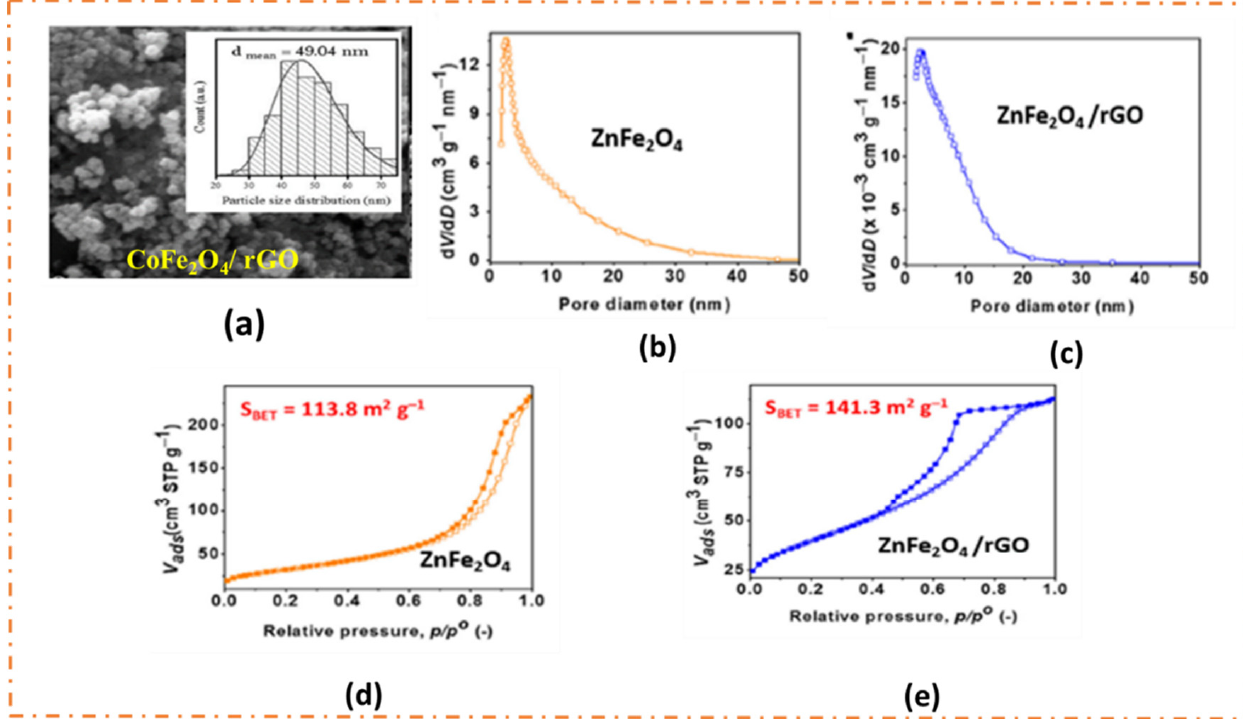
Figure 2. ( a ) FESEM image of CoFe 2 O 4 /rGO composite “Reprinted/adapted with permission from Ref. [40]. 2020, Elsevier”. BJH adsorption pore size distribution curve for ( b ) ZnFe 2 O 4 and ( c ) ZnFe 2 O 4 /rGO; N 2 adsorption–desorption isotherm for ( d ) ZnFe 2 O 4 and ( e ) ZnFe 2 O 4 /rGO (“Reprinted/adapted with permission from Ref. [41]. 2020, Elsevier”.